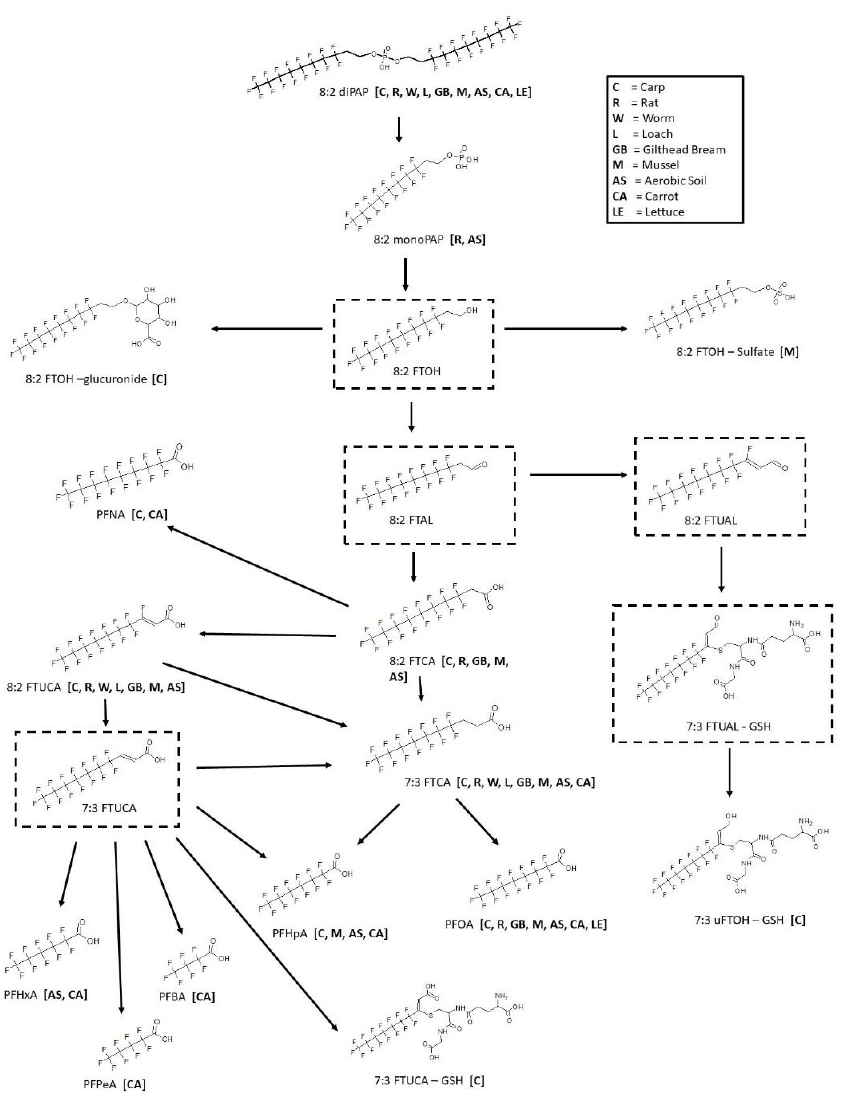
Figure 12. Metabolic map for 8:2 Fluorotelomer phosphate diester (8:2 diPAP) as found in